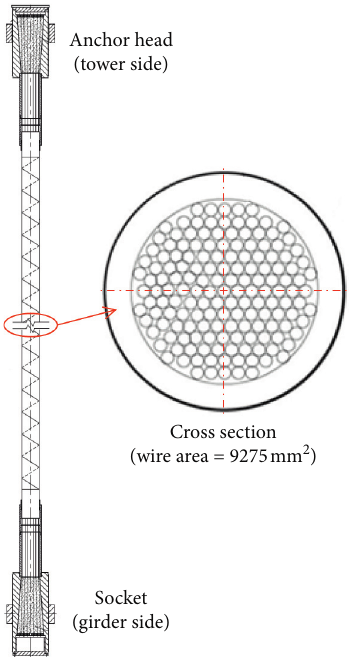
Figure 8: The structure of cable NJ21.